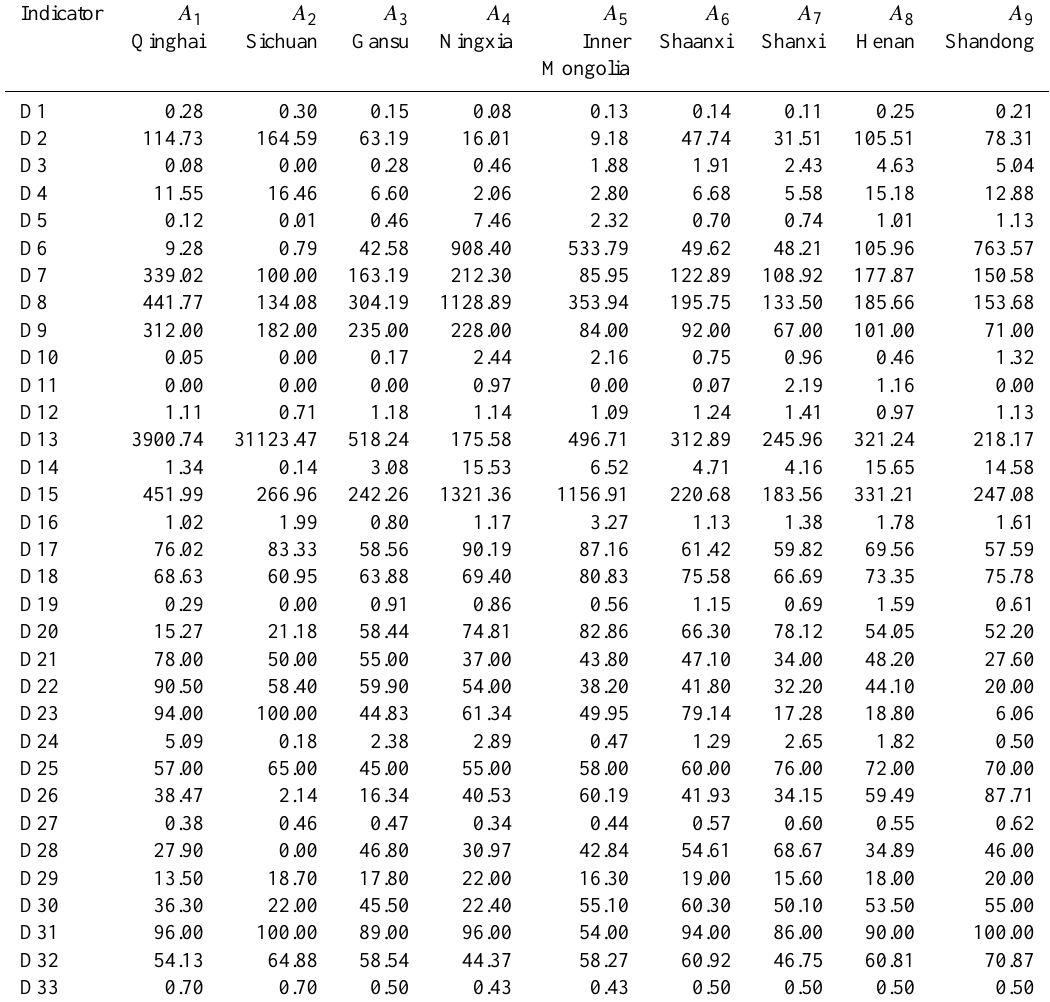
Table 5. Indicator value of nine provinces in the water resources security evaluation system in the Yellow River basin.